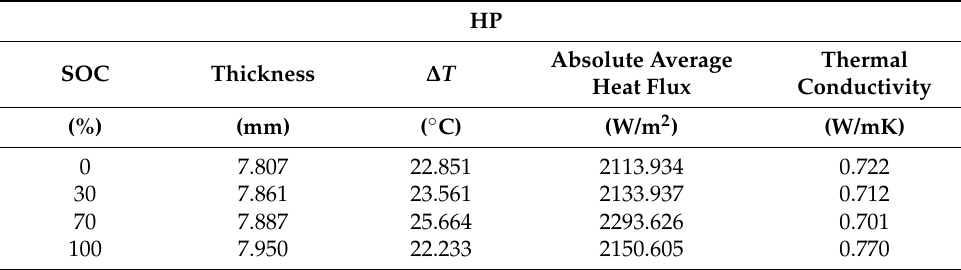
Table A2. Data used to calculate the thermal conductivity of cells aged under high compression.